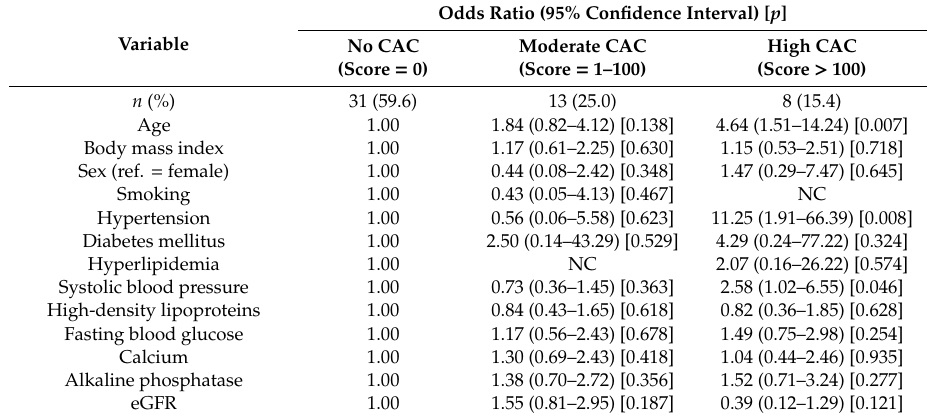
Table 4. Multinomial logistic regression model of demographic and clinical variables for CAC in patients with osteoporosis.